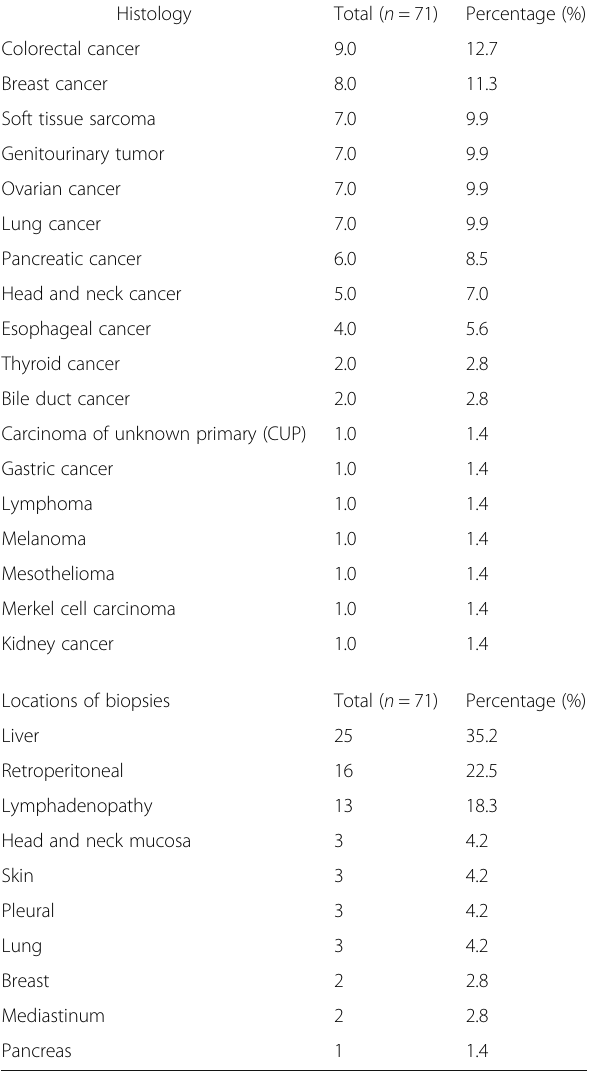
Table 2 Tumor histologies and locations of the biopsies obtained for microarray analysis of the patients in the training set